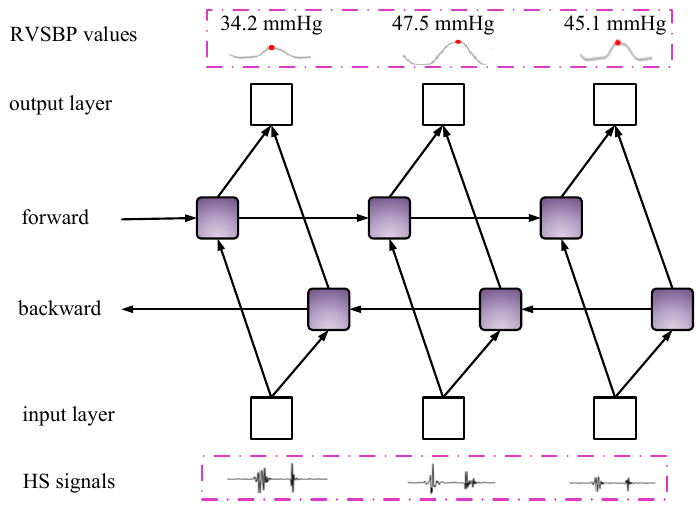
Figure 5. A Bidirectional Long Short-Term Memory (BI-LSTM) network.